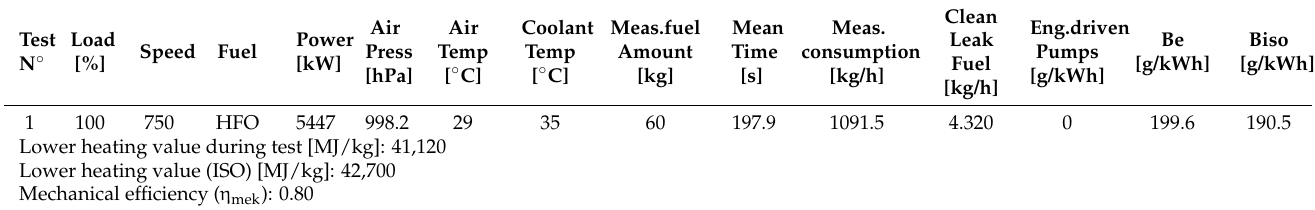
Table 1. Tests conditions and results for genset